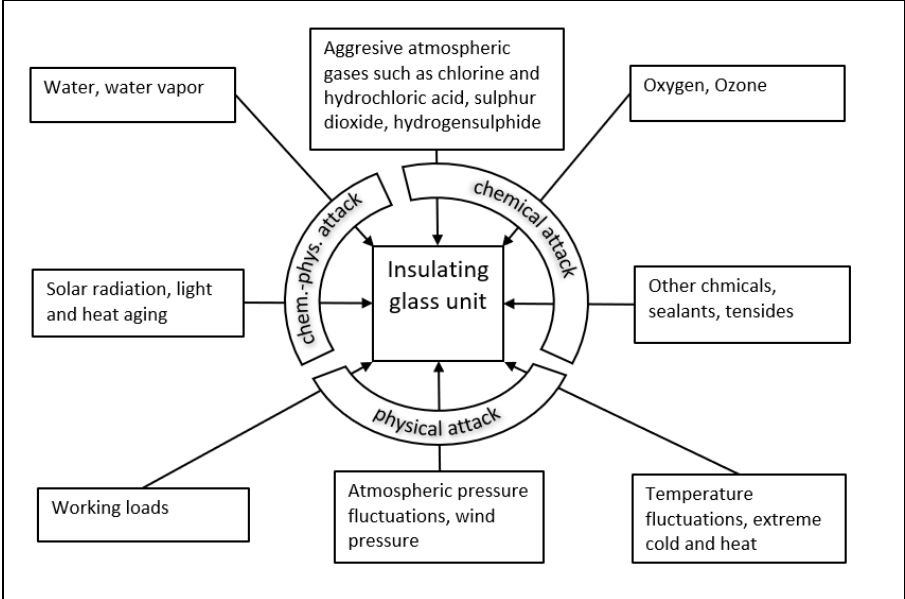
Figure 4. Environmental Influences on Aging Process of Insulating Glass [13].